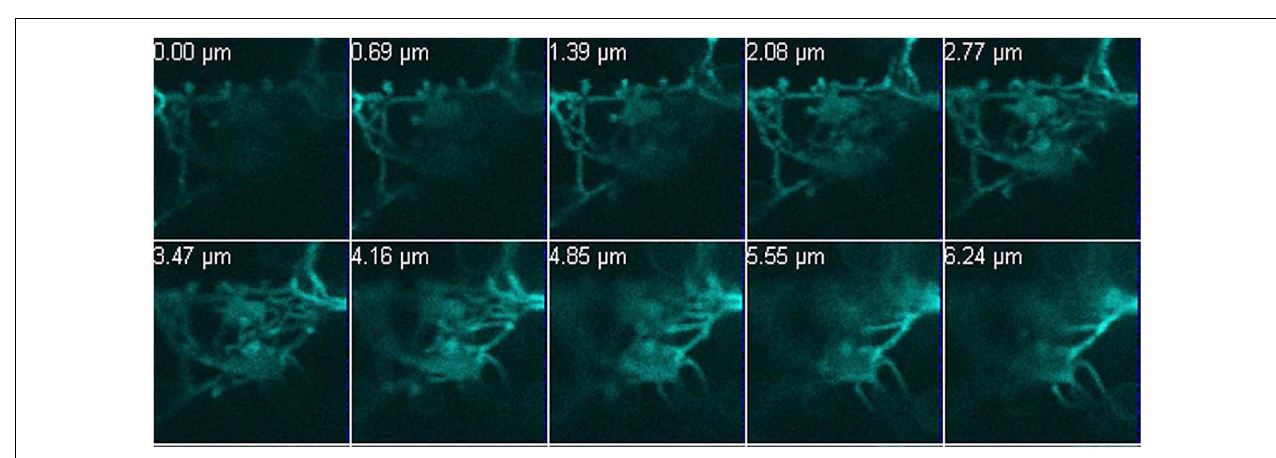
protoplast.The appropriate scale bar is included in the Figure 1 .The images were taken with the Confocal Laser Scanning Microscope LSM 510 META, Zeiss.